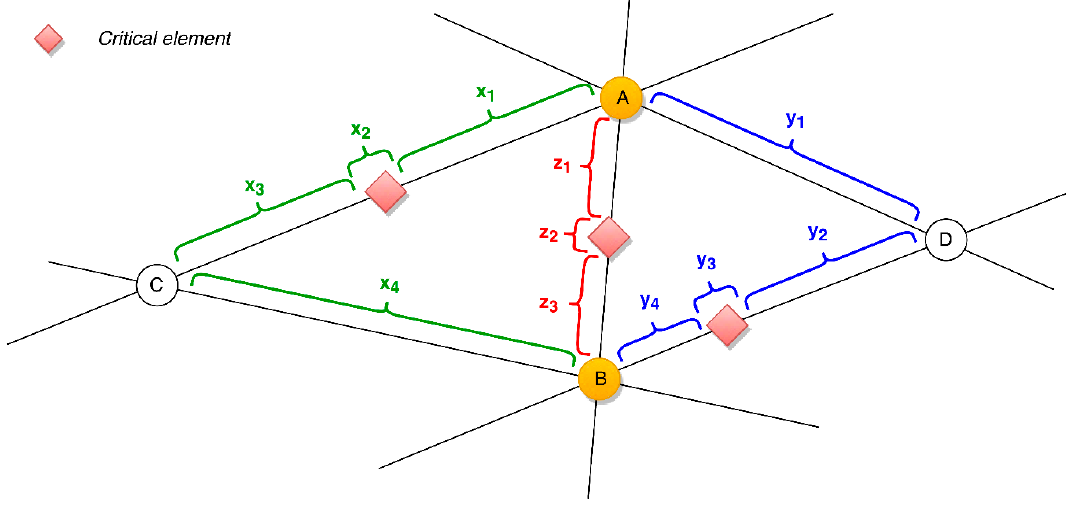
Figure 10. Graphic depiction of detour roads divided into given segments.